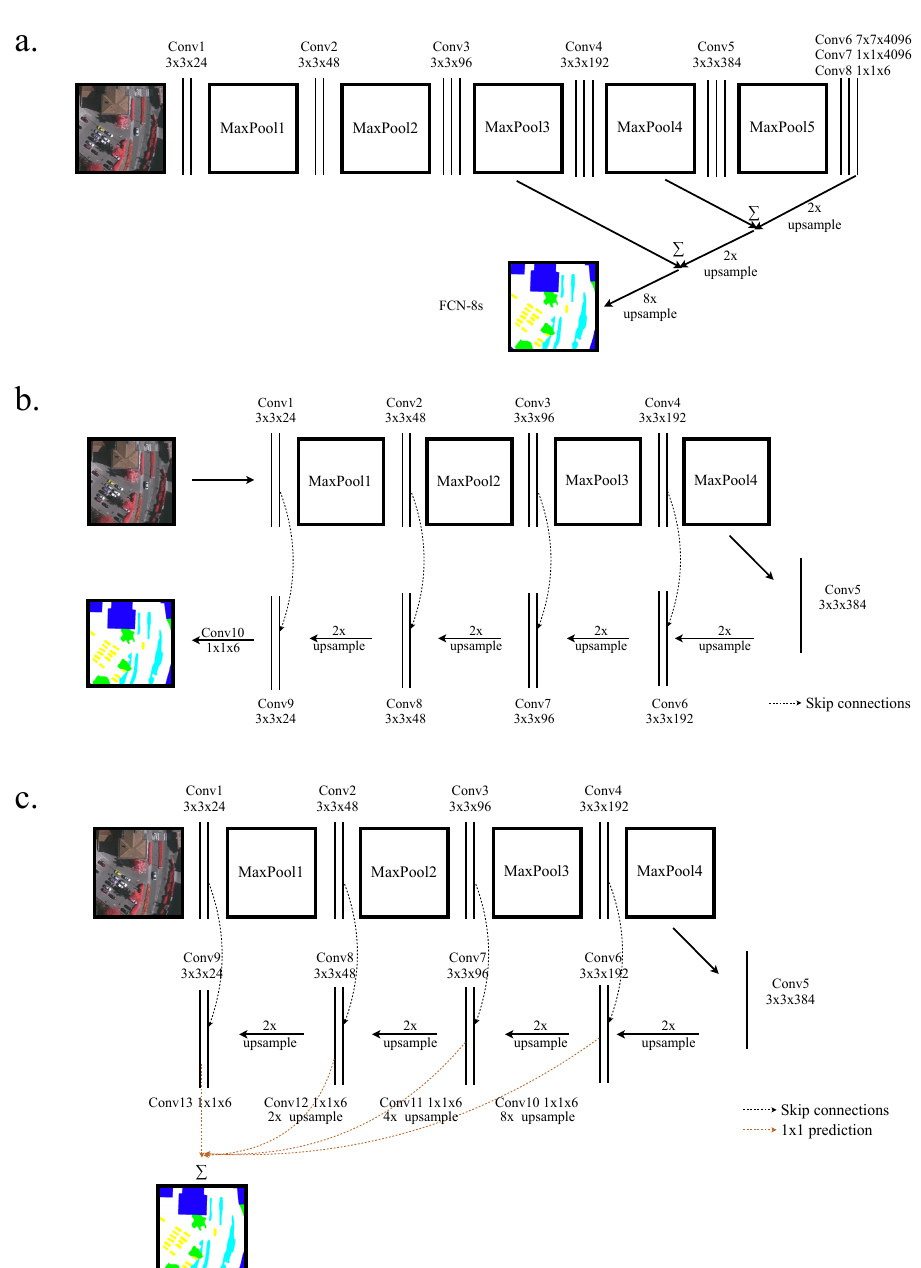
Figure 4. Specification of three basic models: ( a ) FCN-8s, ( b ) U-Net, and ( c )